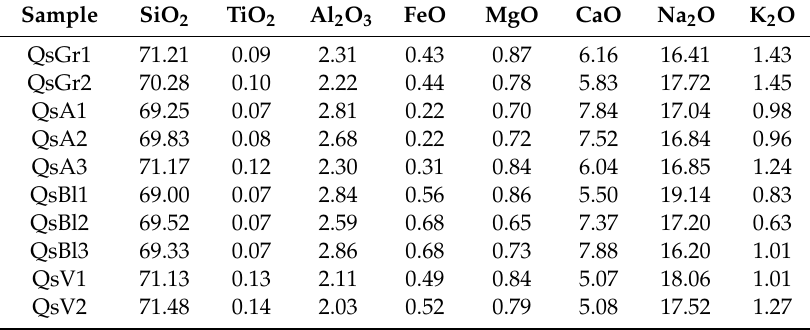
Table 3. Composition of base glass in wt.% of oxides normalized to 100% without MnO, PbO,